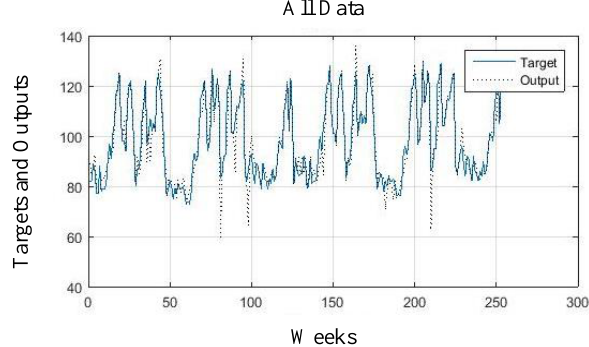
Fig. 7. Comparison of targets and outputs for ANFIS model.